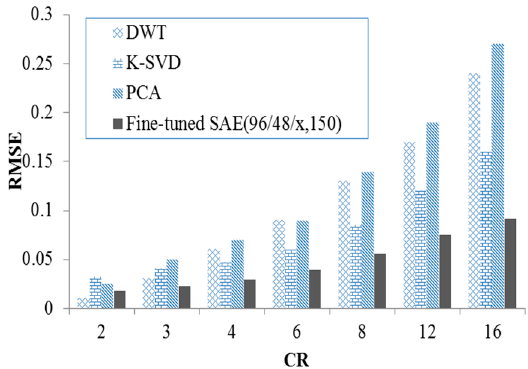
Figure 10. Comparison of SAE and linear algorithms.